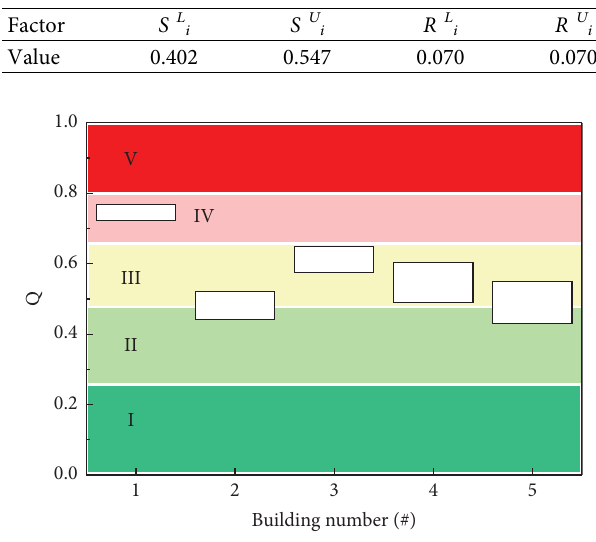
Figure 5: Te buildings risk